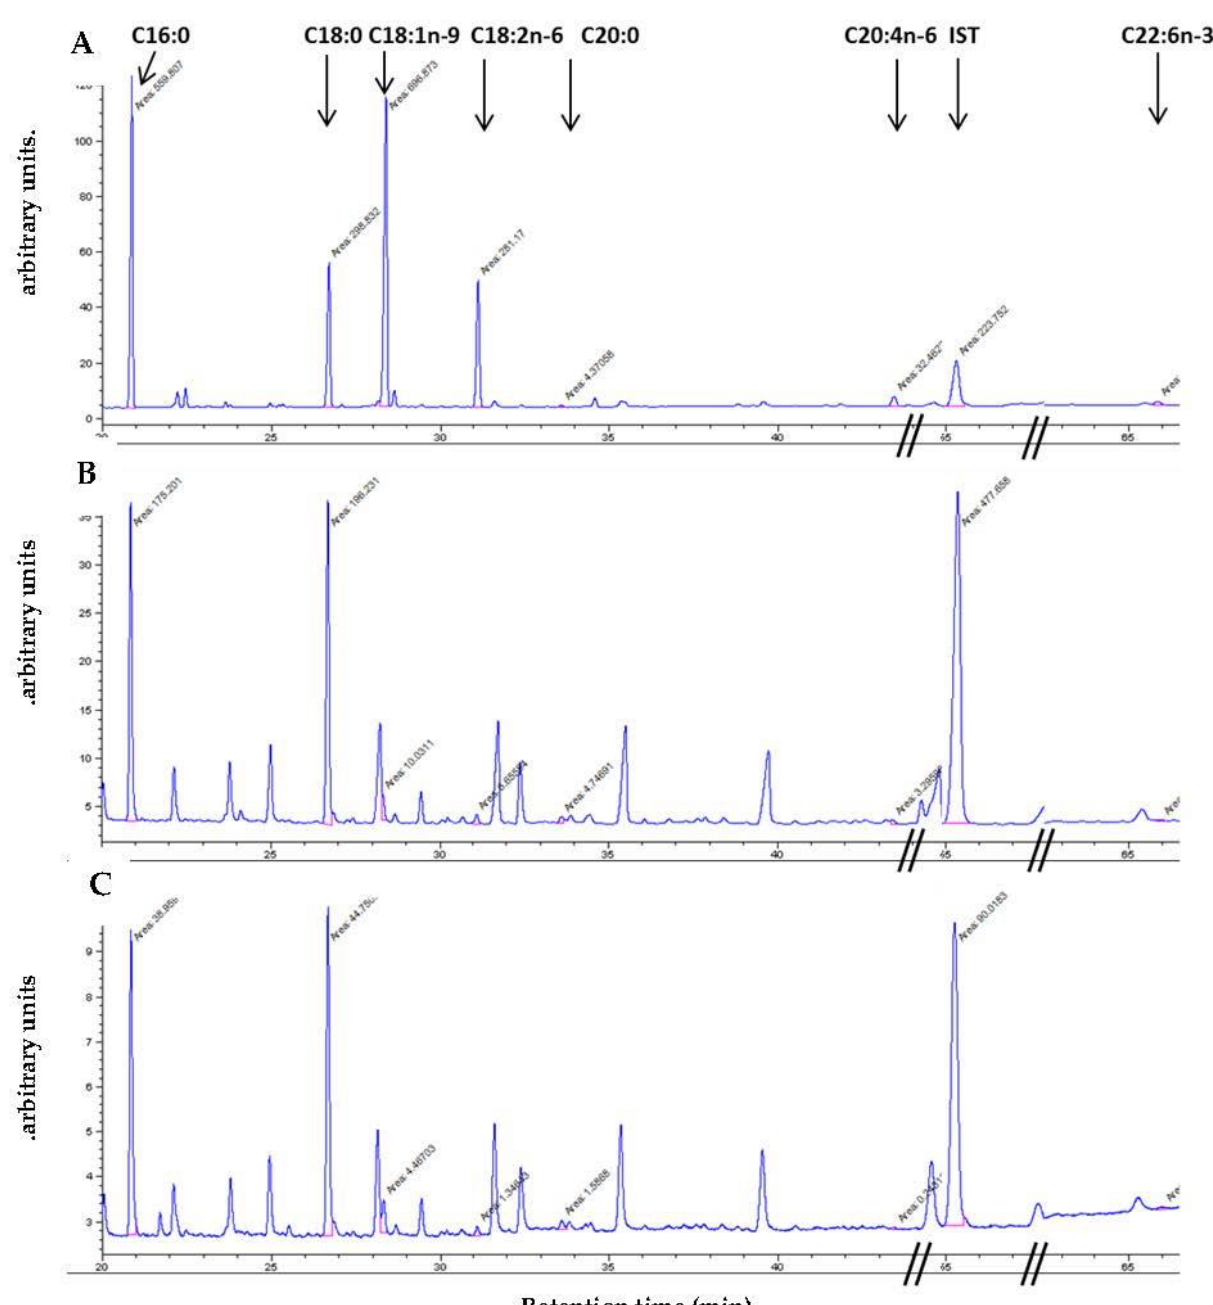
Figure 7. Free fatty acid analysis of human serum and Fet A preparation. Free fatty acid pattern of a representative human serum, Fet A from Sigma-Aldrich, and rhFet A were analyzed as described in the Method section. ( A ) A gas chromatogram of the fatty acid pattern of a serum from a representative healthy individual is shown. ( B , C ) show chromatograms of the fatty acid pattern of commercial Fet A and of rhFet A, respectively. 16:0, 18:0 and 20:0 indicate the saturated fatty acids palmitate, stearate and arachinate; 18:1 indicates the monounsaturated fatty acid oleate and the poly-unsaturated fatty acids as indicated by 18:2 = linoleate, 20:4 = arachidonate and 22:6 = docosahexaenoic acid, respectively; IST = internal standard. Since the areas of the respective peaks are not readable in the original chromatograms they are listed below (arbitrary units): 16:0 559.8, 175.2, 38.95; 18:0: 295.8, 196.2, 44.75; 18:1: 696.8, 10.0, 4.47; 18:2: 281.2 6.65, 1.34; 20:0: 4.37, 4.75, 1.58; 20:4: 32.5, 3.29, 0.25; IS: 223.7, 447.7, 90.0 and 22:6: 17.9, 1.3, 0.71 for chromatogram A, B, and C, respectively.